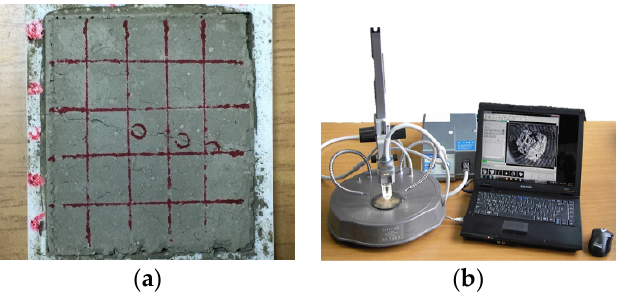
Figure 8. Observation of crack: ( a ) marking of crack area in disc specimens, ( b ) observation of cracks in disc specimens using a microscope.